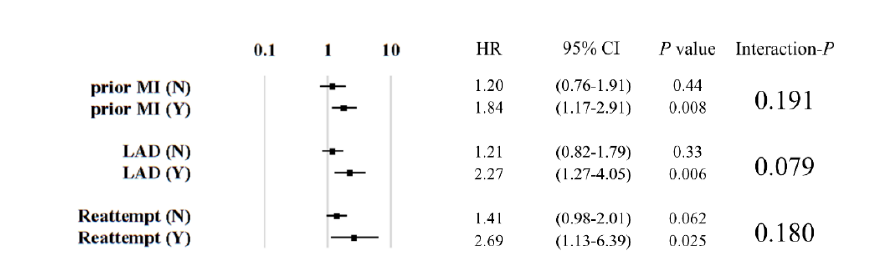
Figure 6. Effect modifiers with statistical trends on the association between successful CTO-PCI and 1-year MACCEs. Abbreviations: CI, confidence interval; LAD, left anterior descending artery; MI, myocardial infarction.